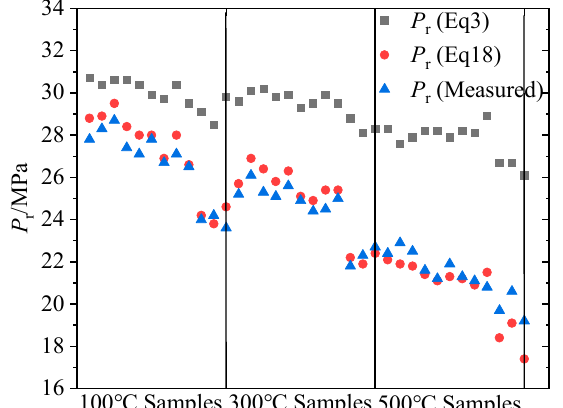
Figure 15. Variation of measured and calculated reopening pressure with temperature for all lithological samples.